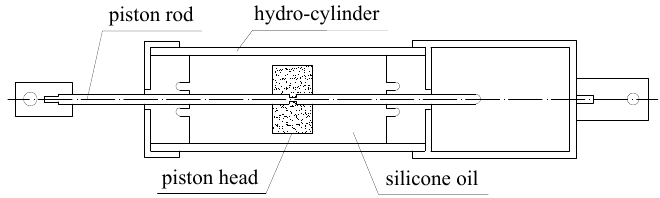
Figure 1. Schematic Diagram of Fluid Viscous Damper.